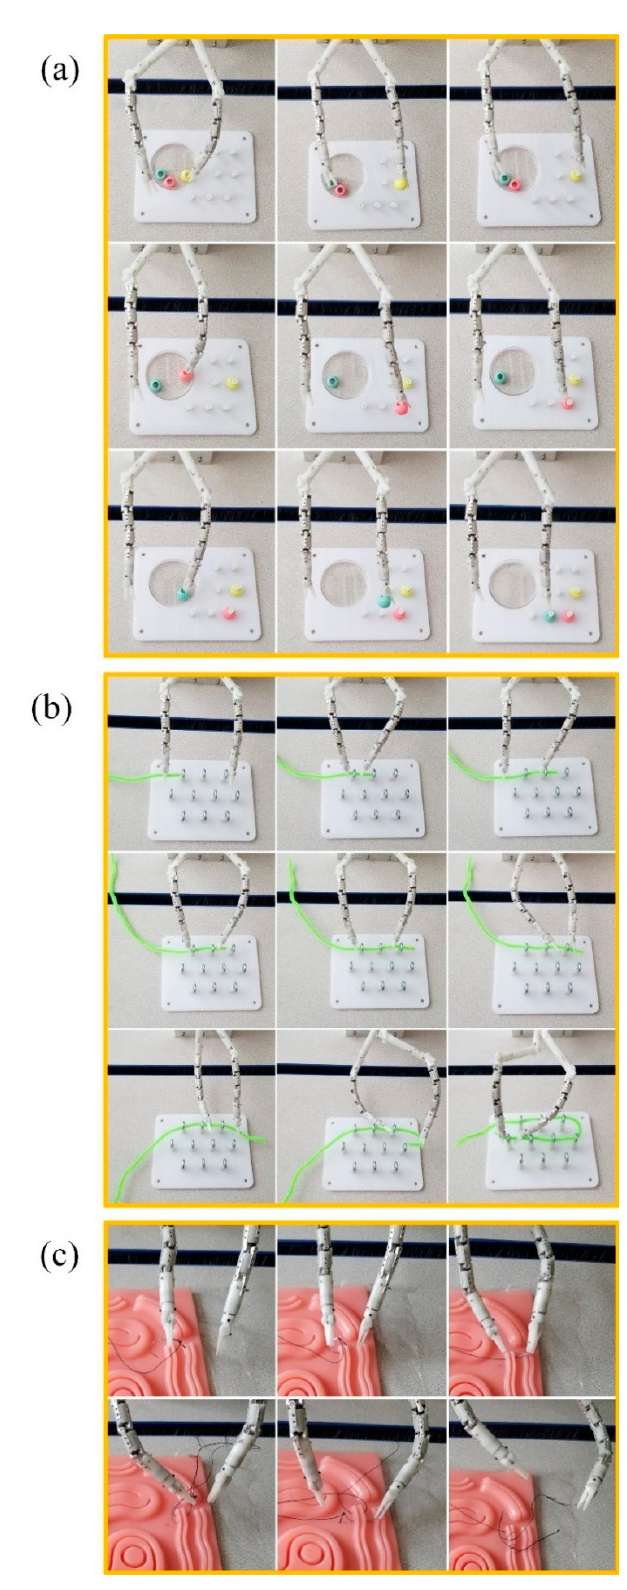
Figure 11. Experiments on the platform: ( a ) single-port surgery system small ball picking test; ( b ) single-port surgical system snake-shaped perforation test; ( c ) suture operation test of single hole surgical system.